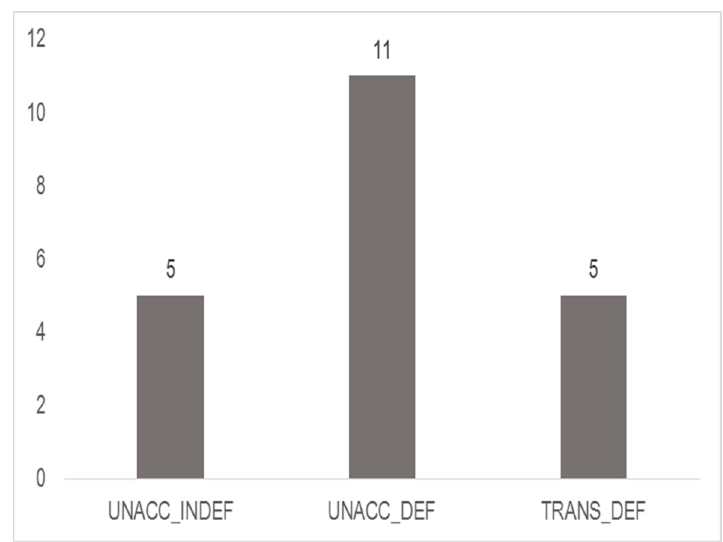
Figure 3. Raw frequencies of different verb-argument configurations instantiated by constituent-verb-subject-(object) structures. UNACC_INDEF: unaccusative verb followed by